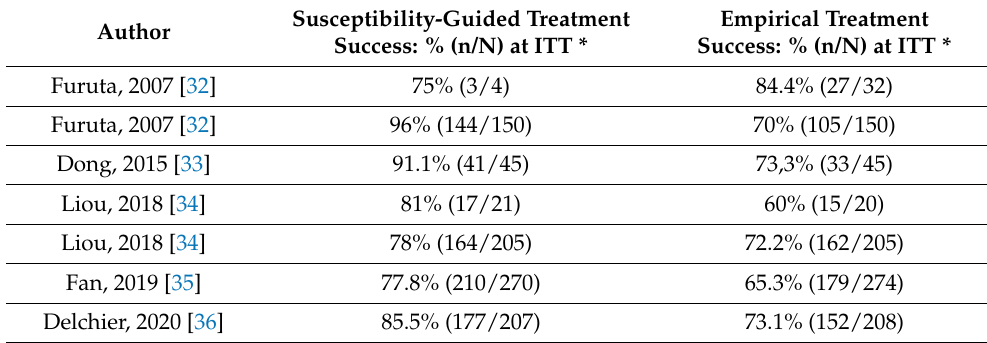
Table 2. Studies evaluating guided versus empirical treatment after PCR resistance